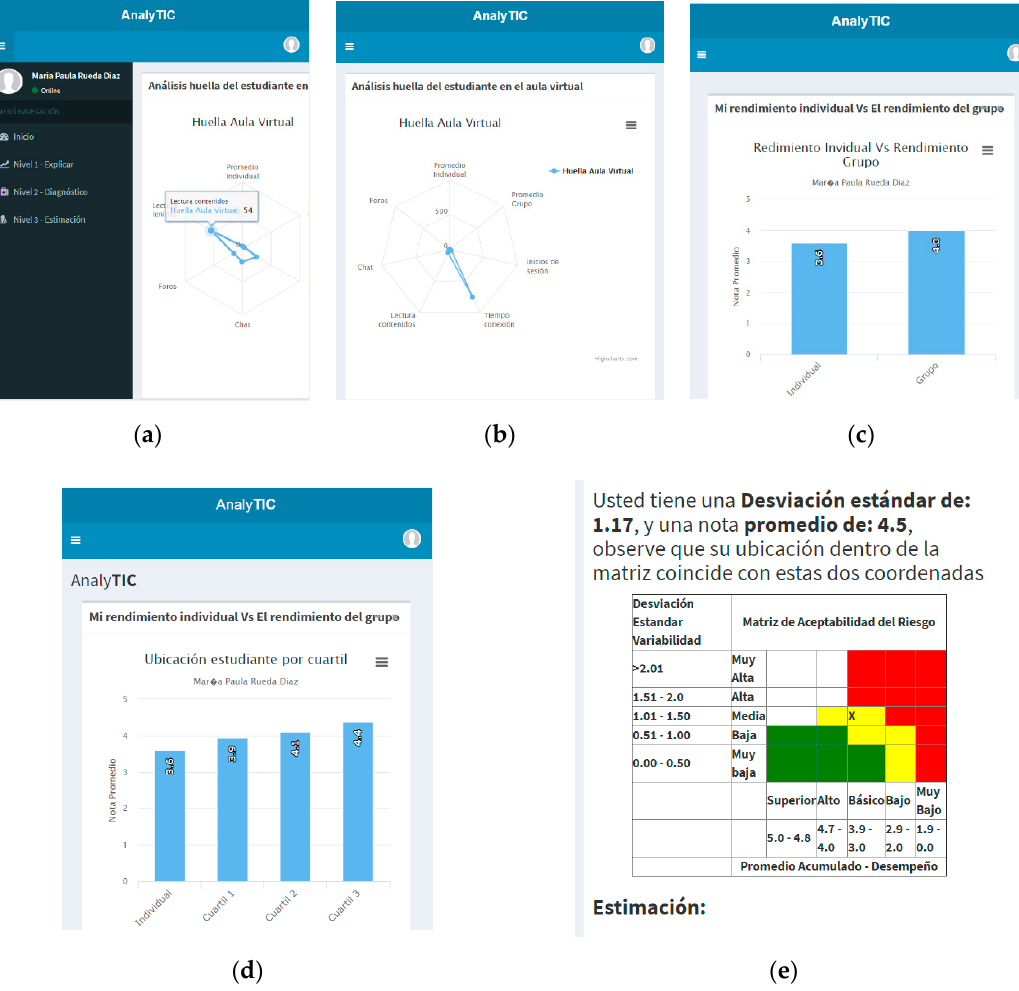
Figure 8. ( a ) Display of the main menu options for the student profile, with options for Home; Level 1—Explanation; Level 2—Diagnosis; and Level 3—Prediction. ( b ) Radial graphics showing the main